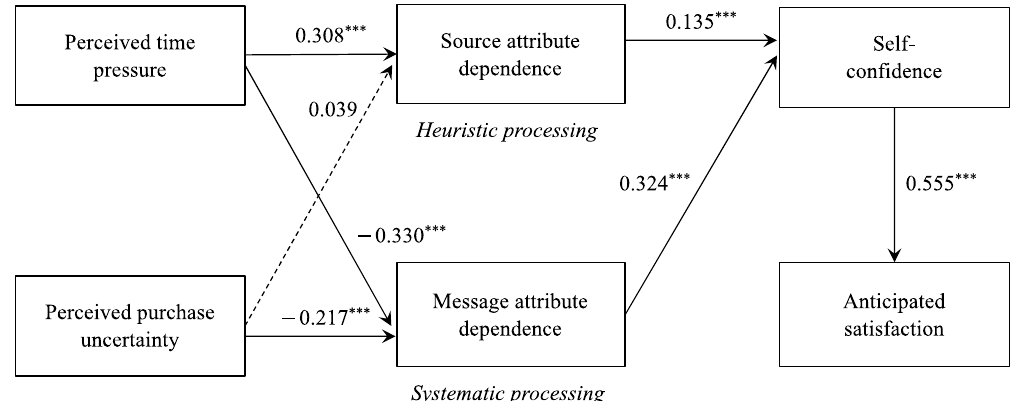
Figure 2. Hypothesis testing. Notes. X 2 = 479.669 ( p = 0.000, df = 216); CFI = 0.964; TLI = 0.957; *** p < RMSEA = 0.047; SRMR = 0.060; *** p < 0.001.